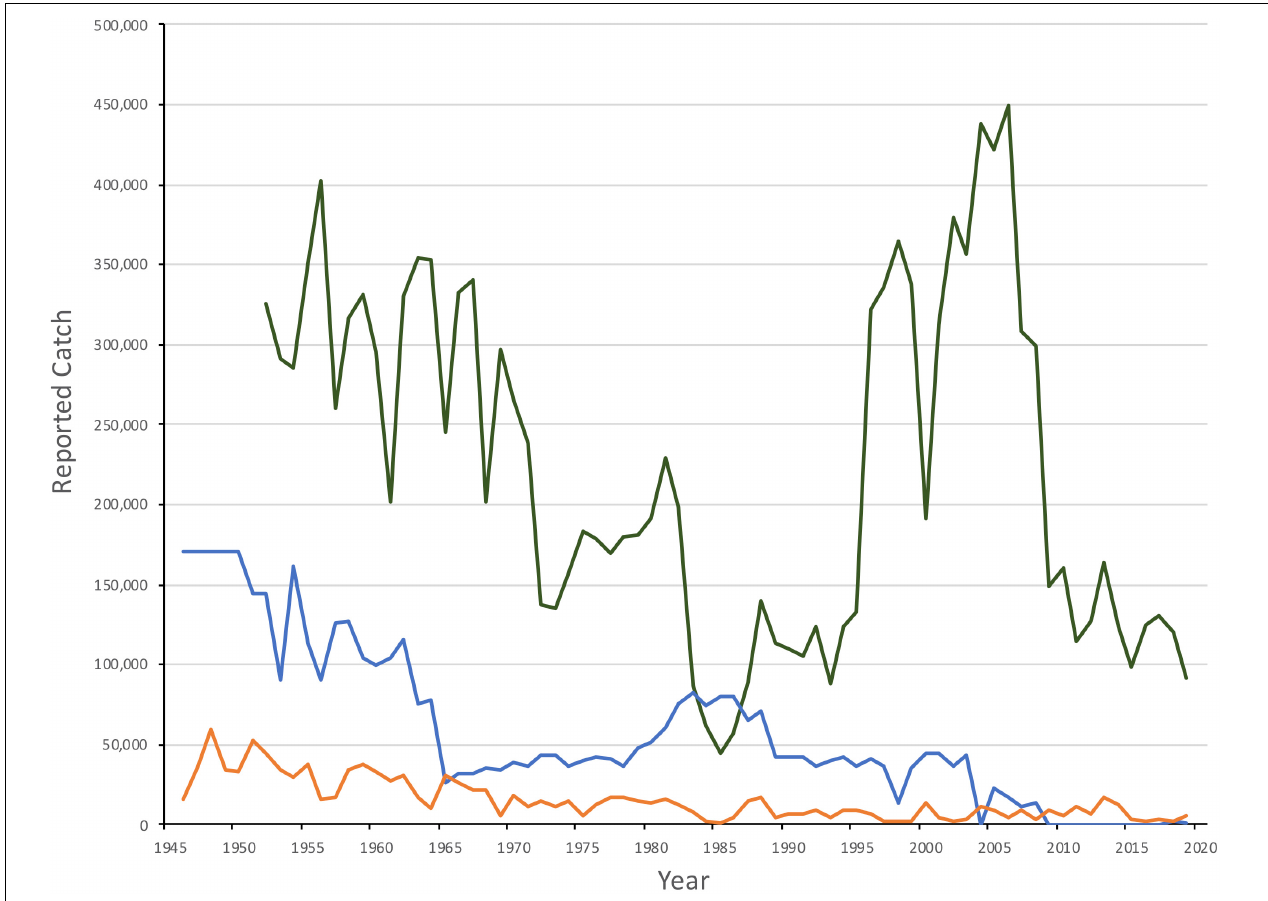
FIGURE 2 | Reported catches of Northwest Atlantic (green), White Sea/Barents Sea (blue) and Greenland Sea (orange) harp seals, 1950–2019. Catches in the White Sea/Barents Sea from 1946-50 is a 5 year average.